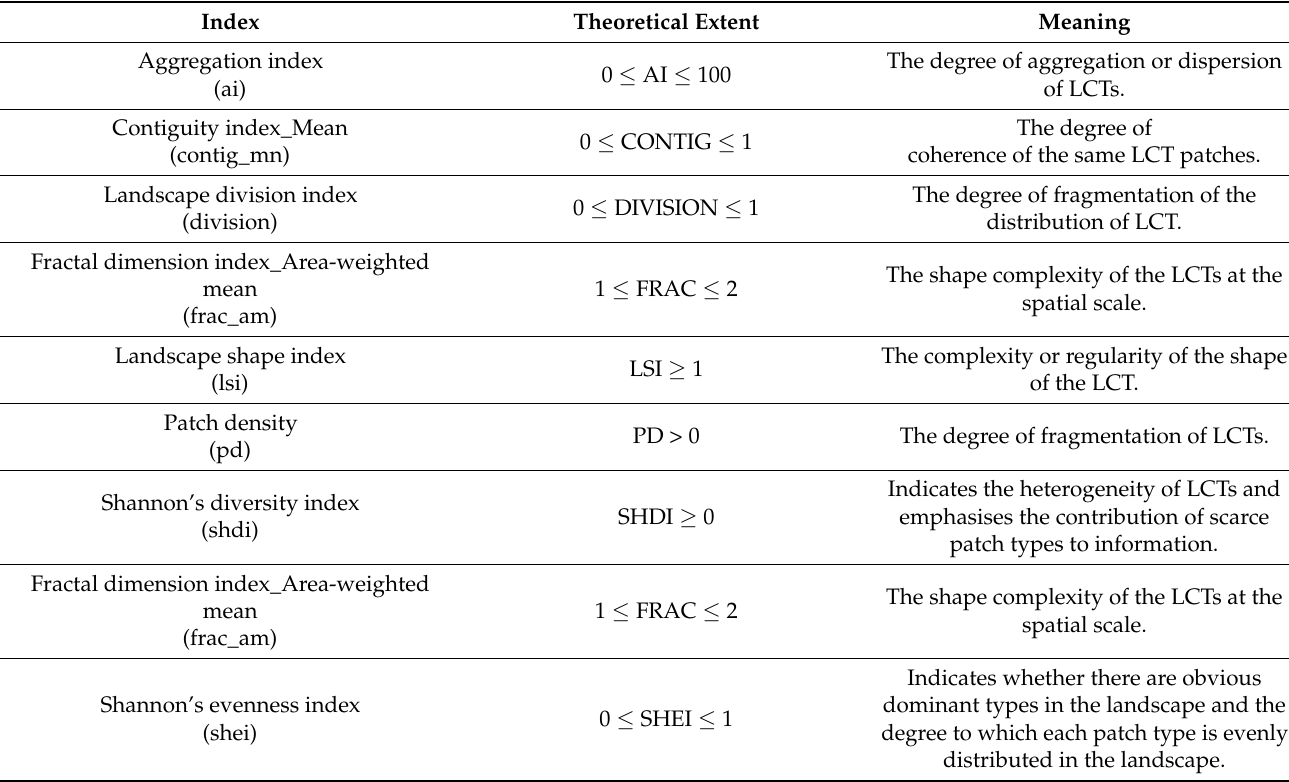
Table A2. Landscape structure factor and its structural meaning.